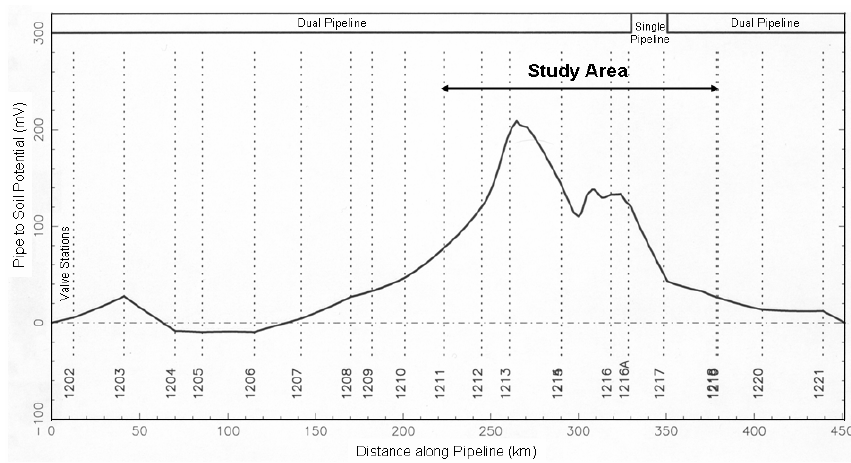
Figure 8. Fig. 8. Modelled PSP for the entire 450km long branch of pipeline from North Bay (km 0) to Morrisburg (km 450). perpendicular to the pipe H ⊥ can be used to calculate the geoelectric field parallel to the